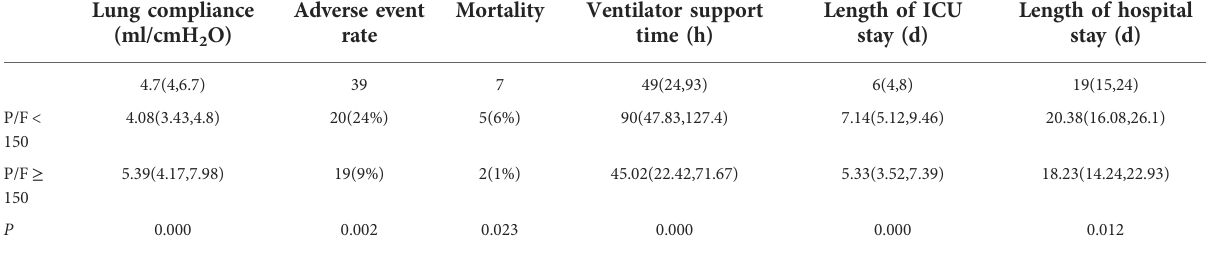
TABLE 3 Comparison of recovery between SLI group and routine group after TOF